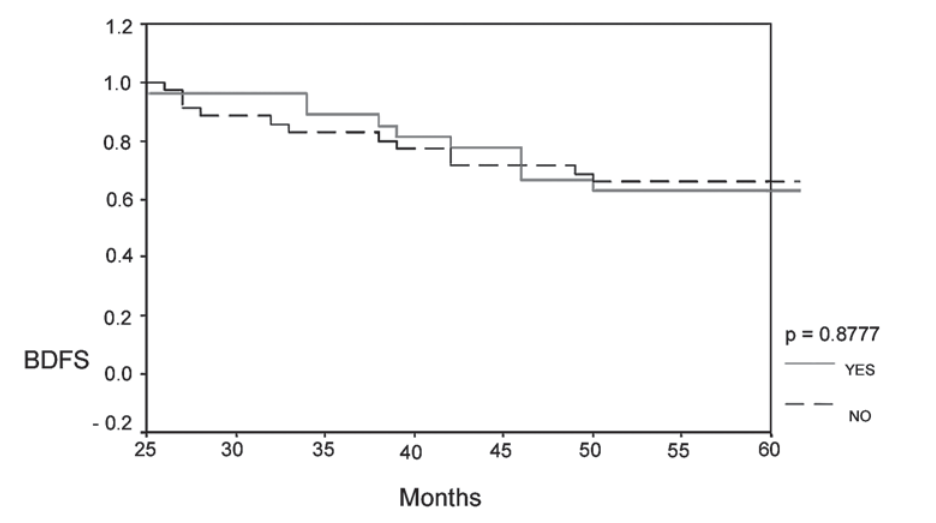
Figure 4 – Five years biochemical disease free survival (BDFS) with neoadjuvant hormone